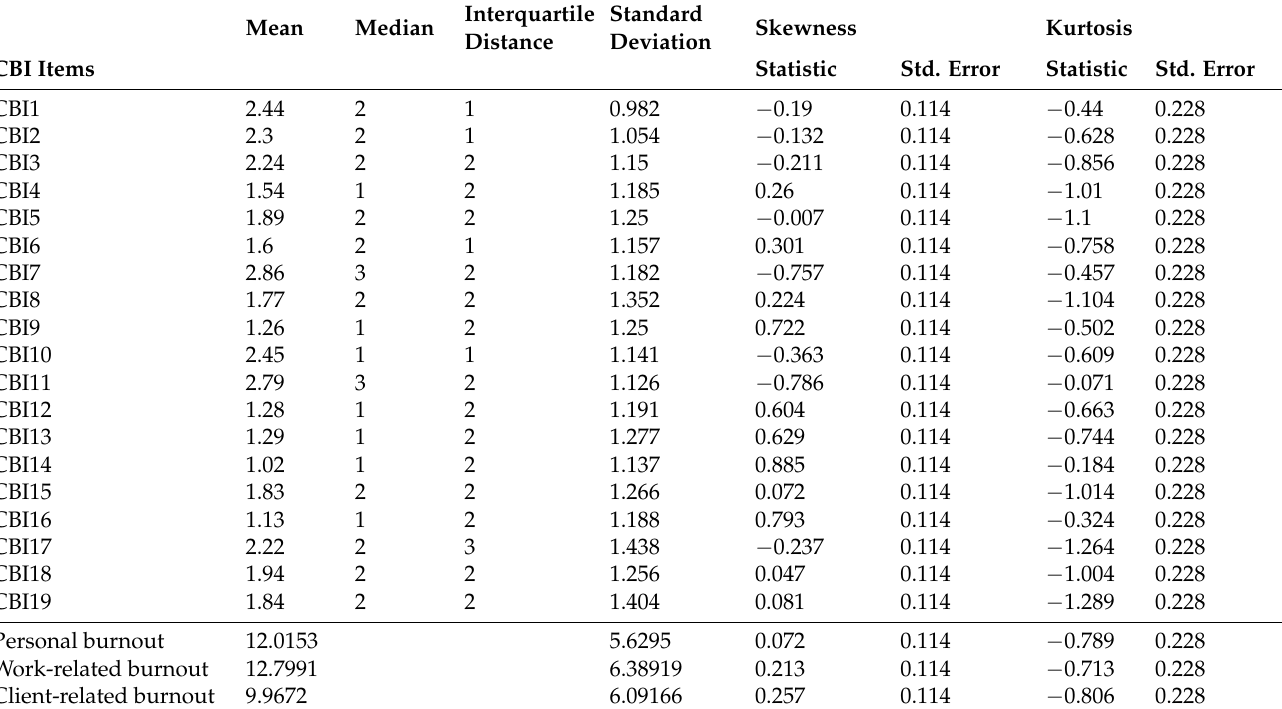
Table 2. Descriptive analysis of the CBI items—sample